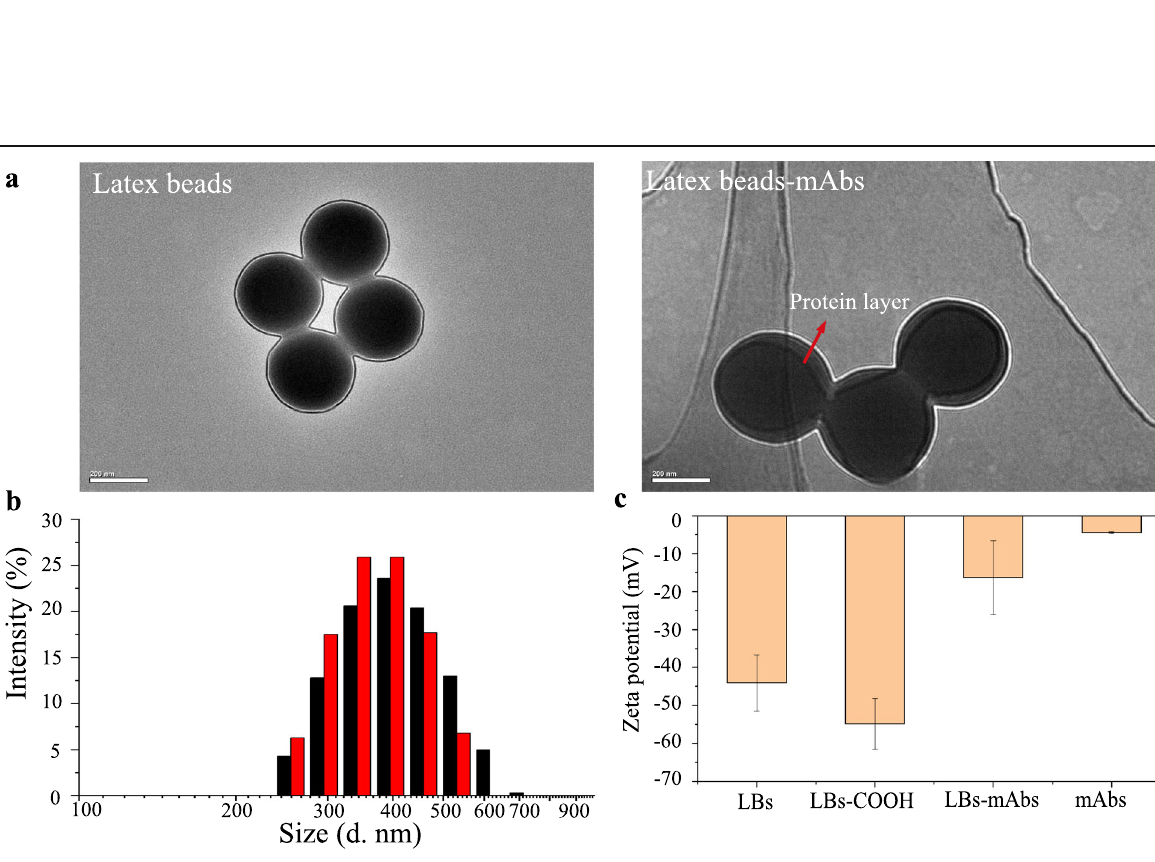
Fig. 2 Characterization of the LBs-mAbs. a TEM images of LBs and LBs-mAb. b Hydrodynamic diameter distribution of LBs and LBs-mAbs. c Zeta potential distribution of LBs, activated LBs-COOH, LBs-mAbs and